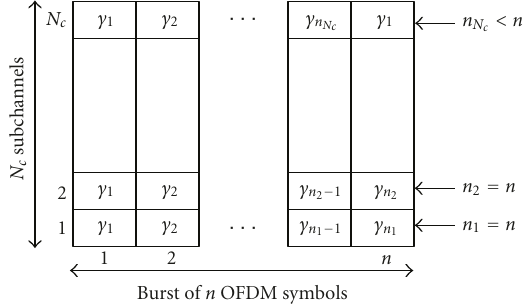
Figure 2: Threshold-based multiuser scheduling in WiMAX